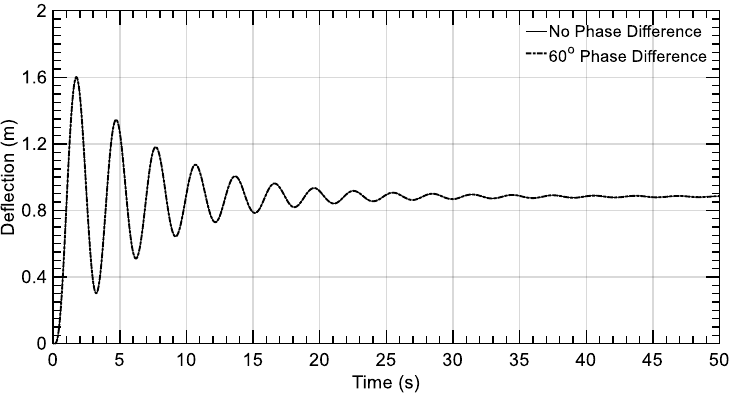
Figure 22. Tower-base, fore-aft bending moment.